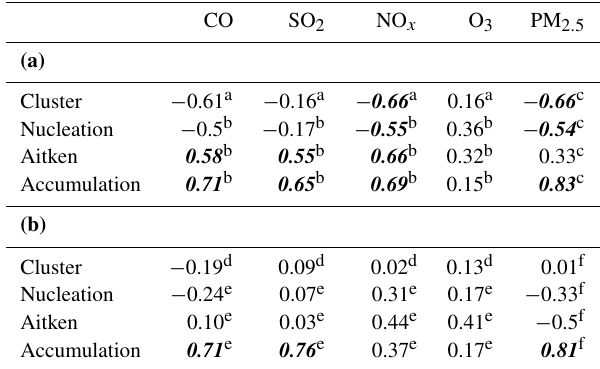
Table 1. (a) Correlation coefficients between size-segregated parti- cle number concentrations and trace-gas mixing ratios and PM 2 . 5 concentration on the NPF event days. (b) Correlation coefficients between size-segregated particle number concentrations and trace- gas mixing ratios and PM 2 . 5 concentration on the haze days. The time window was 08:00–14:00LT. High correlation coefficients ( | R | > 0 . 5) are marked in bold and